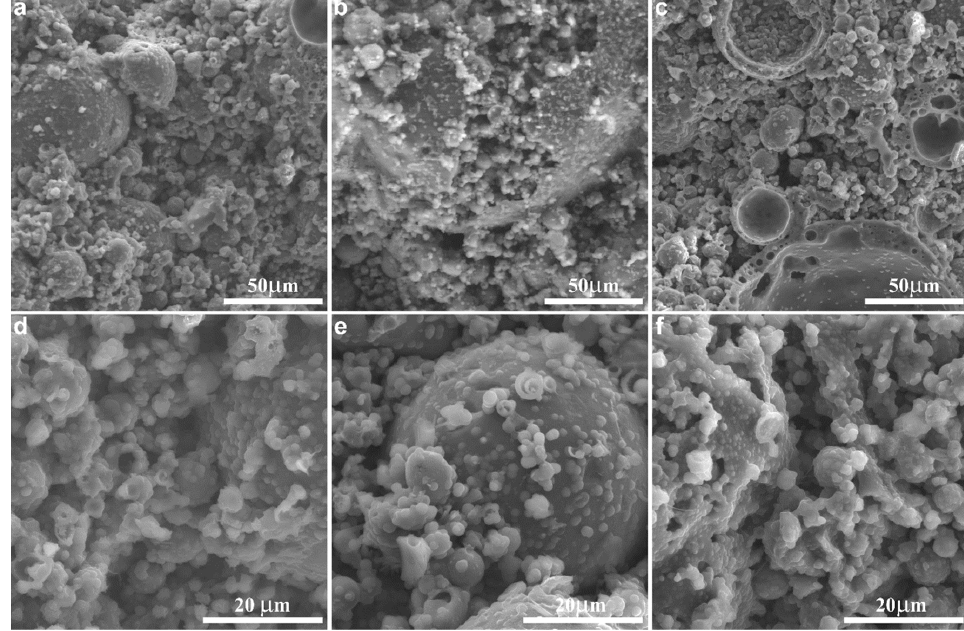
Figure 6. SEM images of the geopolymers reference sample ( a , d ), with BX ( b , c ) and BA ( e , f ). B/Al = 0 ( a , d ), 0.030 ( b , e ), and 0.150 ( c , f ).